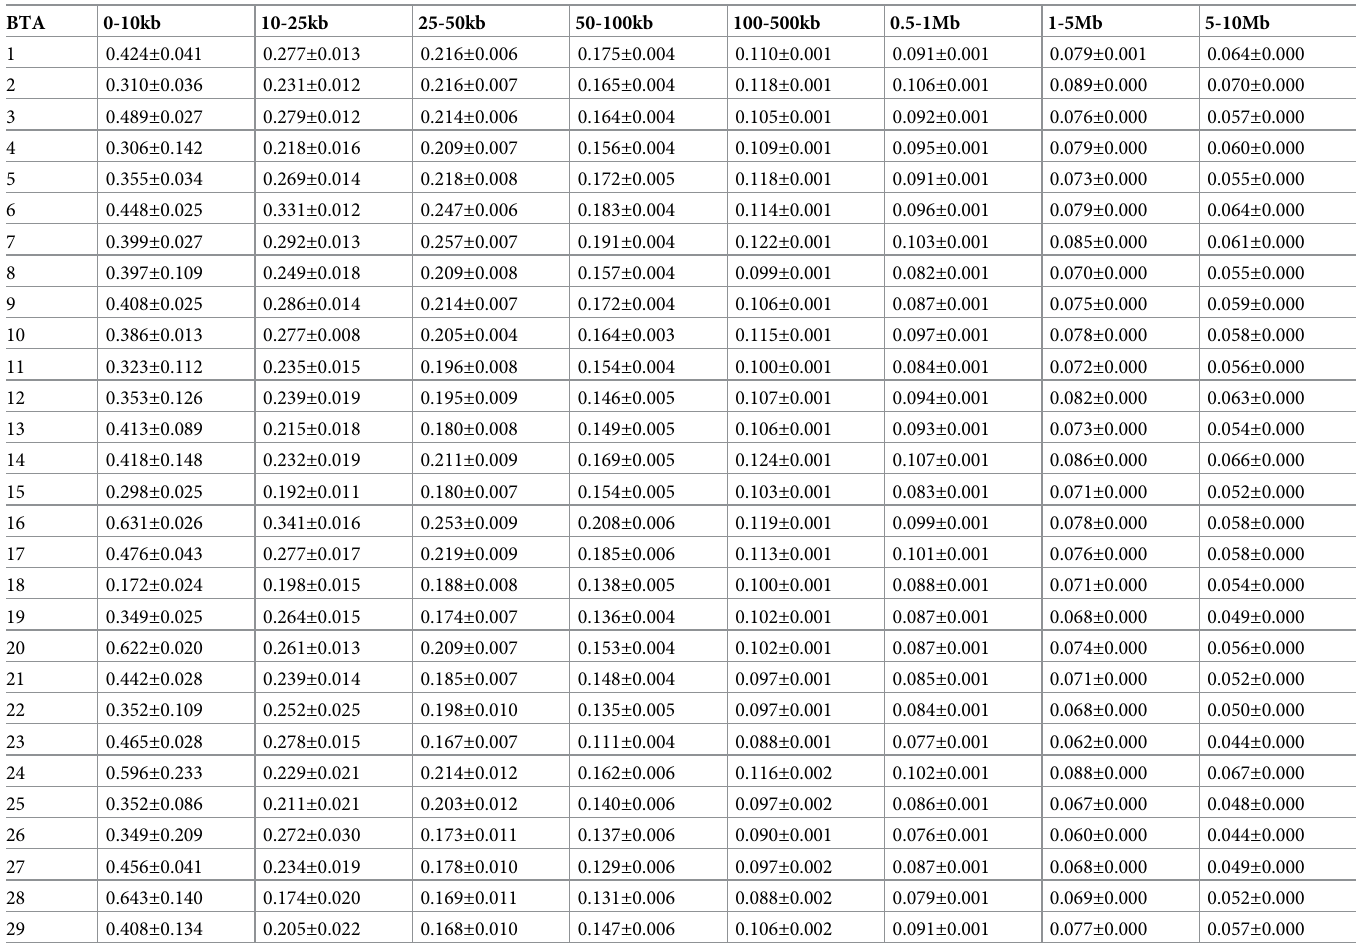
Table 4. Statistical information for mean r 2 as physical distance between SNP pairs up to 10 Mb for the genome.